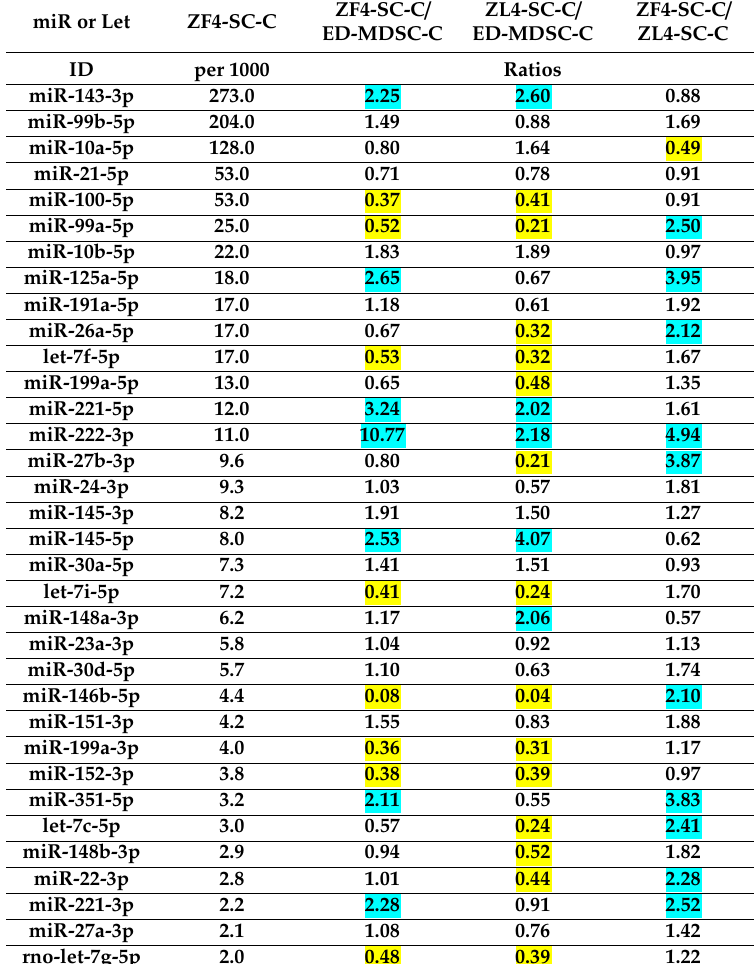
Table 1. The untreated ZF4-SC and ZL4-SC from the pelvic muscles from 12 weeks old female ZF (Zucker fatty) and ZL (Zucker lean) rats have distinctive miR-GTS (global transcriptional signatures of microRNAs), which also di ff er from the miR-GTS in the untreated ED-MDSC (MDSC from young animals with mild early T2D / O) from the gastrocnemius of age-matched male ZF rats. miR or Let